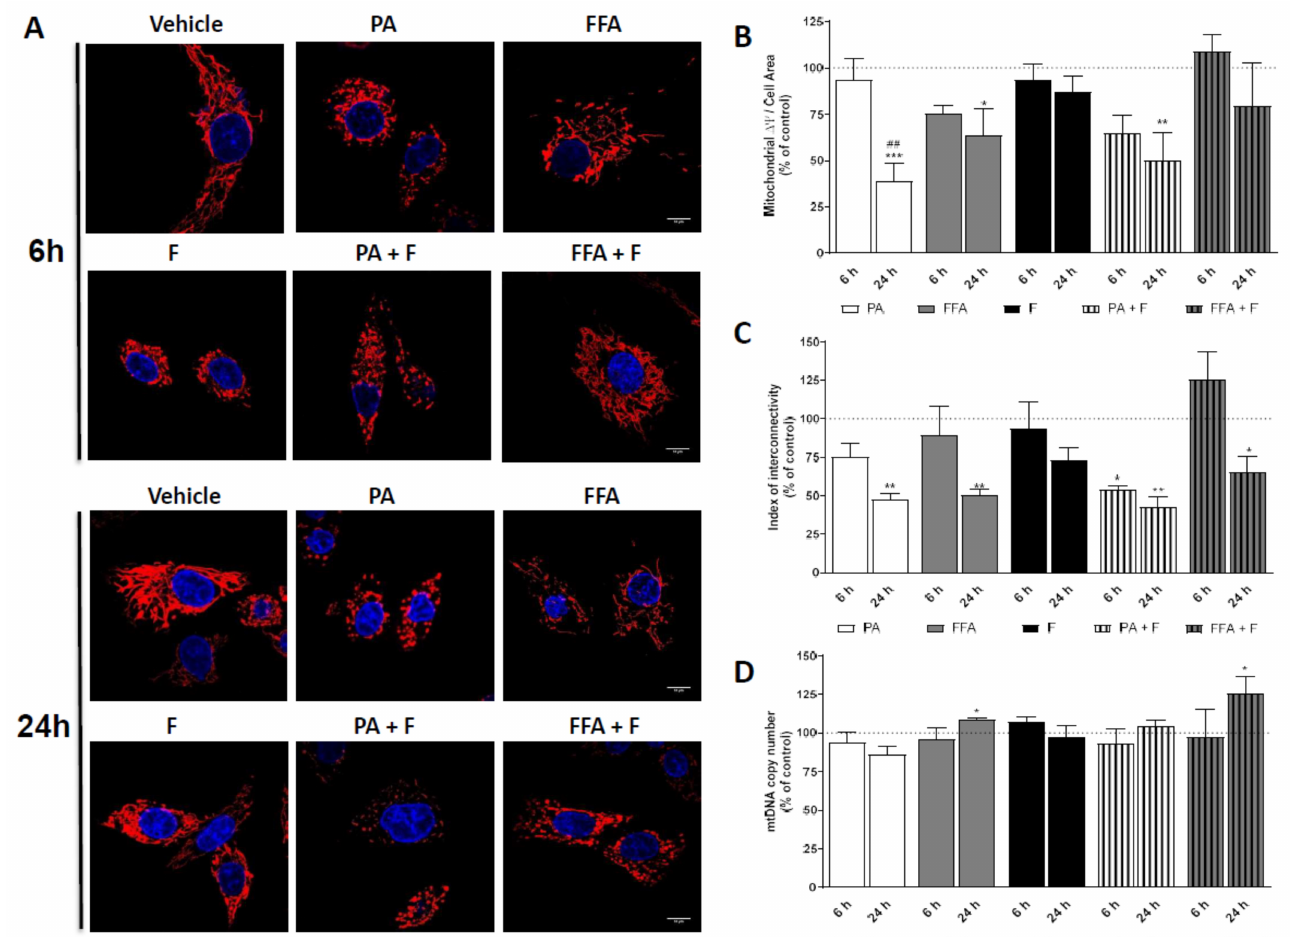
Figure 3. Effect of supra-physiological concentrations of FA on mitochondrial morphology and mtDNA copy number. ( A ) Typical background-corrected (COR) image of HepG2 cells stained with the fluorescent cation TMRM and Hoechst 33,342 after treatment with palmitic acid (PA, 0.5 mM) or a mix of free fatty acids (FFA, 0.25 mM) in the presence or absence of fructose (F, 10 mM) for 6 and 24 h. The TMRM and Hoechst fluorescence intensity was color-coded to red and blue, respectively. ( B ) Average mitochondrial TMRM fluorescence intensity calculated from the images. ( C ) Index of mitochondrial interconnectivity calculated from the images ( D ) mtDNA copy number in HepG2 cells treated with PA or FFA in the presence or absence F for 6 and 24 h. mtDNA copy number was based on the amplification of cytochrome B (encoded on the mitochondrial genome) and β -2-microglobulin (encoded on the nuclear genome) ratio. Data are the mean ± SEM of three independent experiments, and the results normalized on the control condition (CTL = 100%, marked by a dotted line). Significance was accepted with * p < 0.05, ** p < 0.01, *** p < 0.0005 for comparisons between treatment vs. CTL (BSA 0.01 g/mL) and ## p < 0.01 for comparisons during time in the same group (24 and 6 h vs. 1